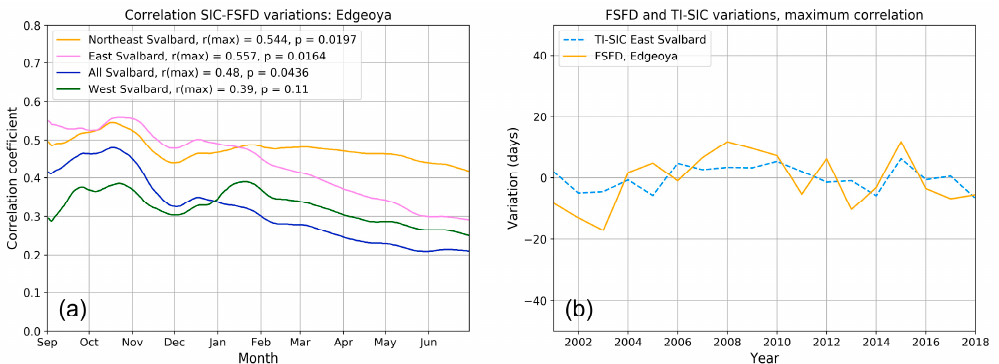
Remote Sens. 2020 , 12 , x FOR PEER REVIEW Figure A2. Mean number of days since the last cloud-free observation for (a) FSFD and (b) LSFD. Figure A2. Mean number of days since the last cloud-free observation for ( a ) FSFD and ( b ) LSFD.